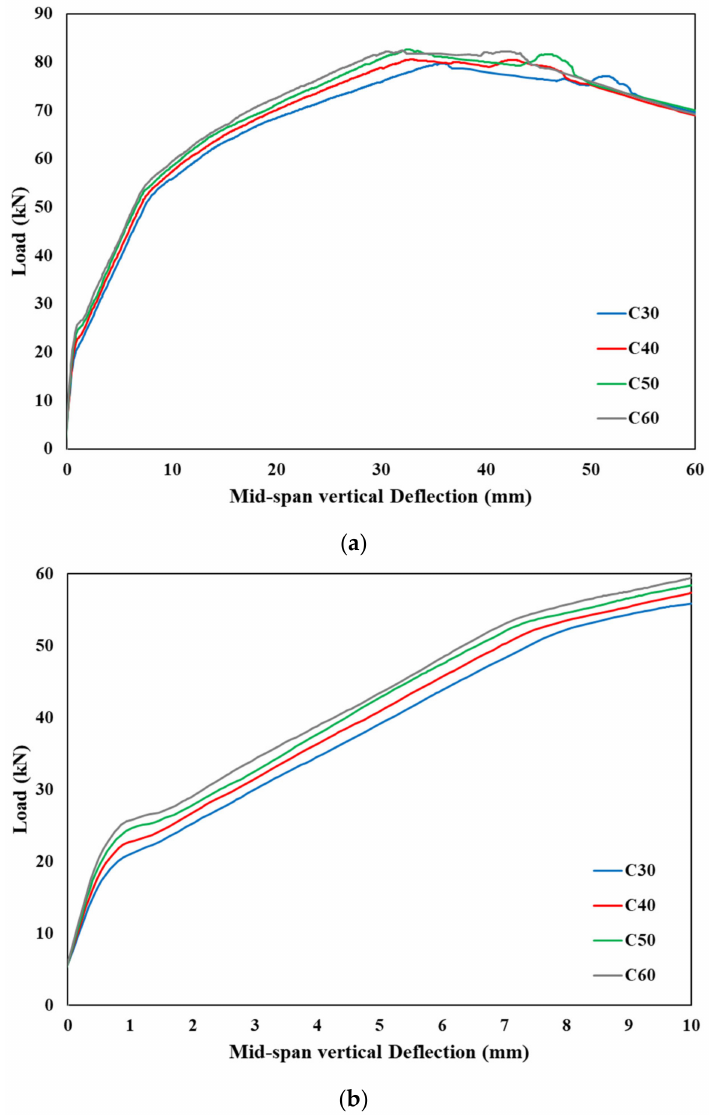
Figure 15. ( a ) Effect of varying the concrete compressive grade on the load-deflection behavior; ( b ) zoom of ( a